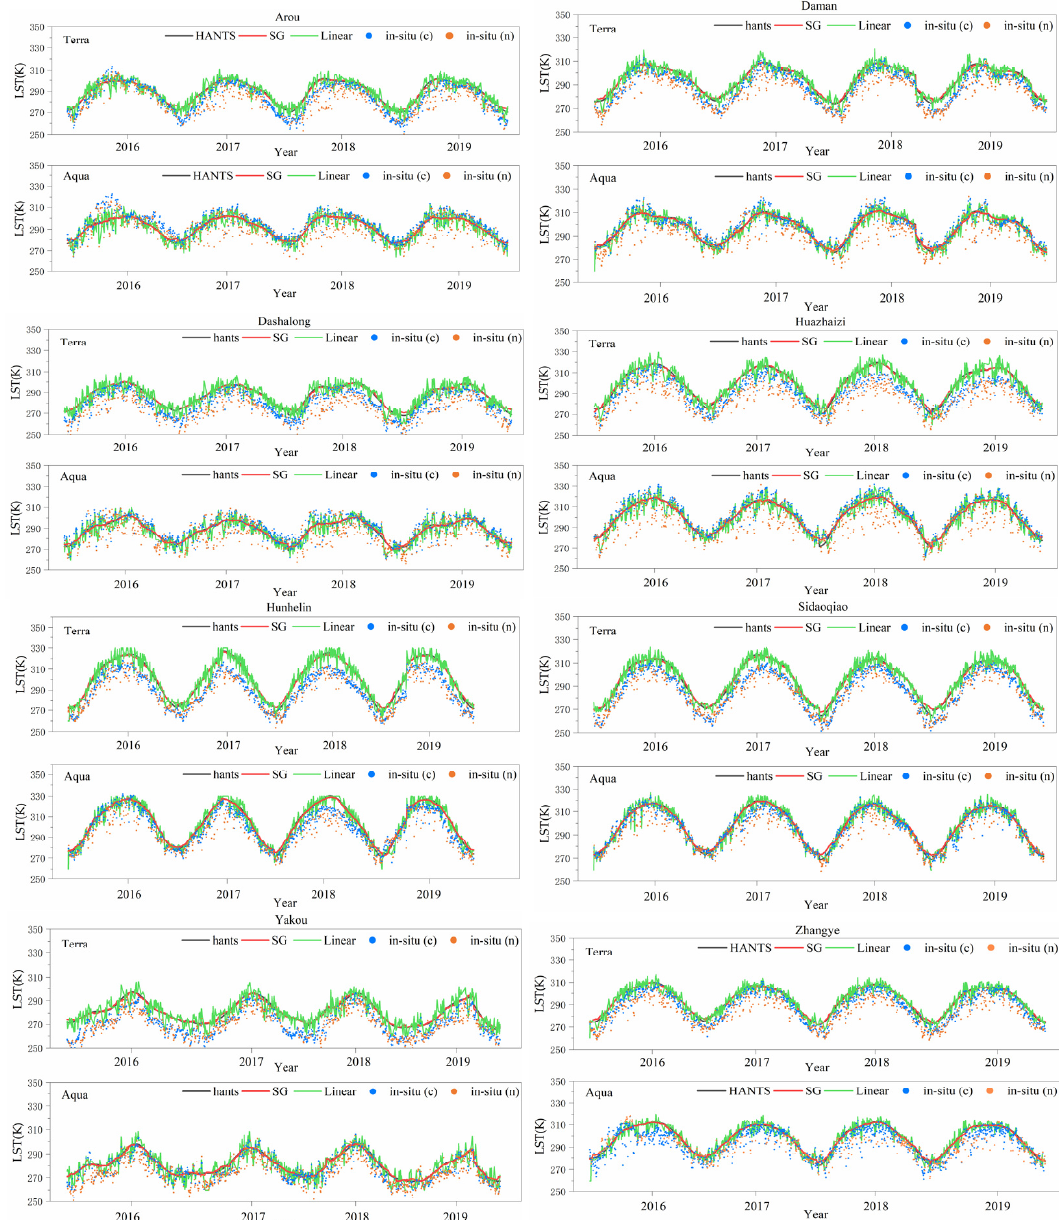
Figure 3. Comparison of reconstructed LST using the temporal method with LST measured by AWS at 8 sites from 2016 to 2019. in situ (n) indicates the measured LST with cloudy skies at the observation station; in situ (c) indicates the measured LST with clear skies at the observation